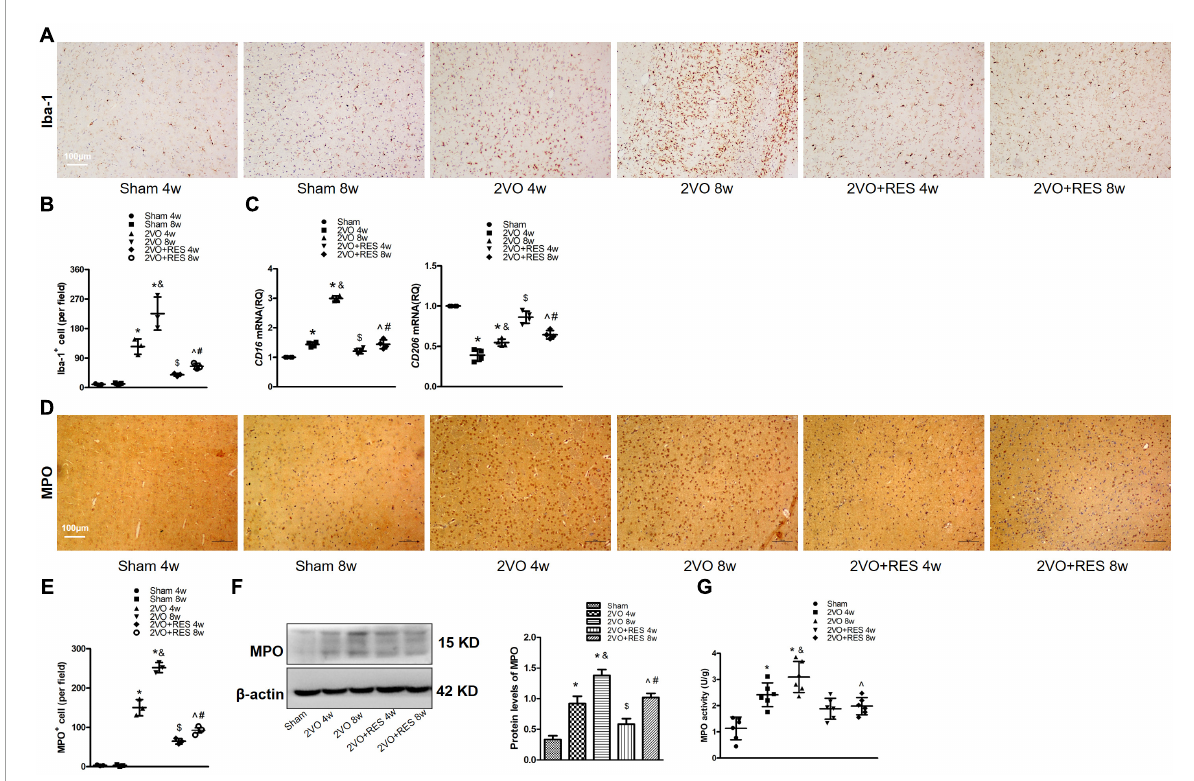
FIGURE7 Increased microglial activity and neutrophil expression at 4 and 8 weeks after 2VO. Resveratrol (RES) treatment inhibits gliosis and neutrophil expression in white matter induced by bilateral common carotid artery occlusion (2VO). (A) Assessment of microglial proliferation and activation. Representative images of Iba-1-stained white matter in each group ( n = 3 per group, × 100, scale bar, 100 µ m). (B) Quantitation of Iba-1 positive cells in white matter. (C) Quantitative analysis of mRNA levels of CD16 and CD206. GAPDH was used as an internal control ( n = 4 per group). (D) Representative images of Immunohistochemical staining for myeloperoxidase (MPO) in the white matter of rats after 2VO ( n = 3 per group, × 100, scale bar, 100 µ m) (E) Quantitative analysis of the number of MPO-positive cells. (F) Western blot and quantification of MPO protein expression in white matter. β -actin was used as an internal control ( n = 3 per group). (G) MPO activity was examined by ELISA in white matter in different groups at 4 and 8 weeks after 2VO ( n = 6 per group). * p < 0.05 vs. Sham; & p < 0.05, 2VO 8w group vs. 2VO 4w group; # p < 0.05, 2VO + RES 8w group vs. 2VO + RES 4w group; $ p < 0.05, 2VO + RES 4w group vs. 2VO 4w group; ˆ p < 0.05, 2VO + RES 8w group vs. 2VO 8w group. Data are presented as mean ±